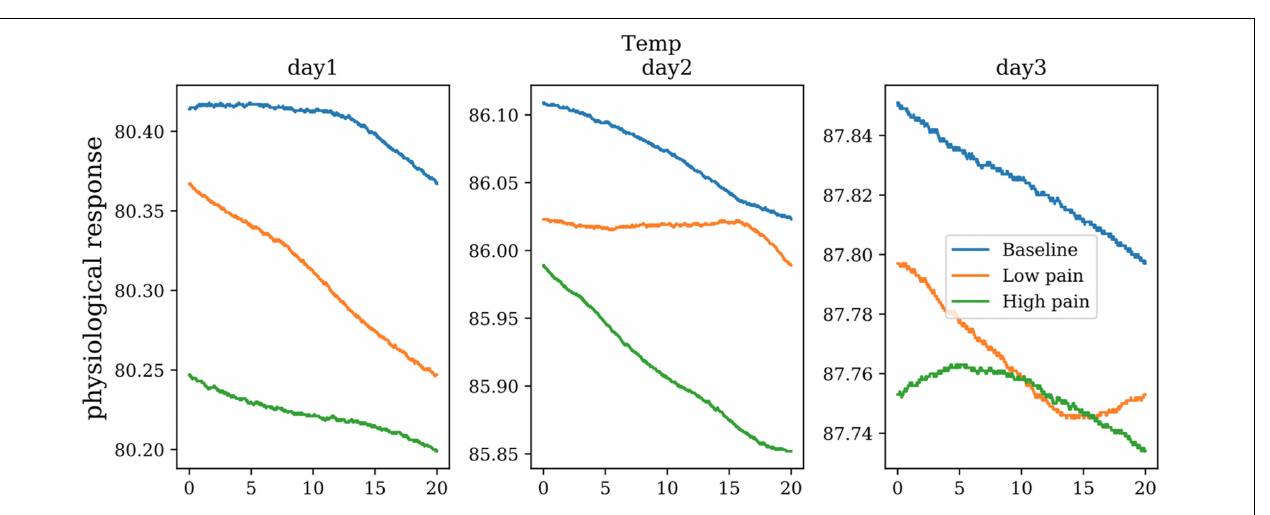
FIGURE 10 | The respiration rate of one subject on three repeated days.